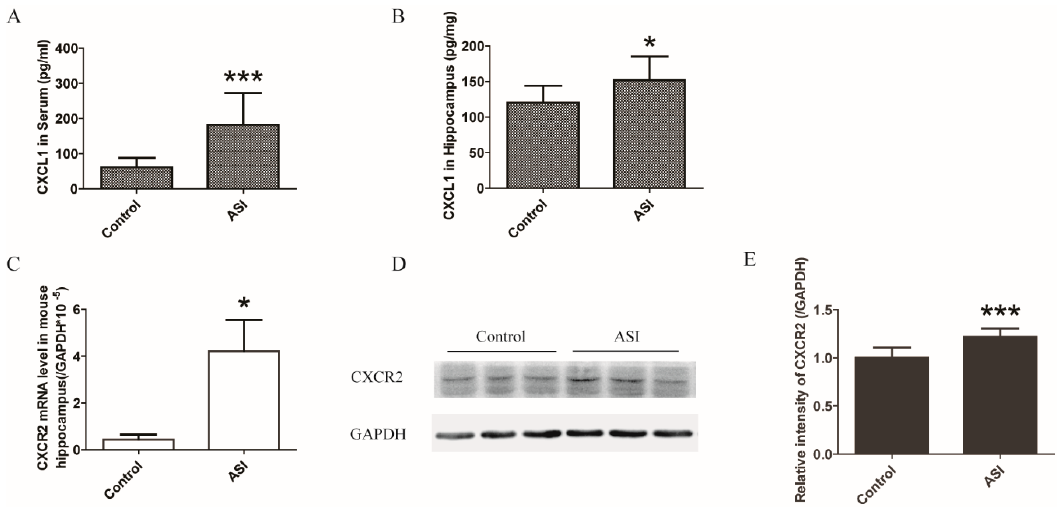
Figure 6. ASI (25 mg/kg) promoted neurogenesis through CXCL1/CXCR2 signaling pathway. ( A , B ) ASI promoted protein expression of CXCL1 in mouse serum and hippocampus ( n = 10/group); ( C ) ASI enhanced CXCR2 mRNA expression level in mouse hippocampus ( n = 6/group); ( D ) Western blotting analysis of CXCR2 in hippocampus; ( E ) Gray intensity analysis of CXCR2 in the hippocampus of mice ( n = 8/group). * p < 0.05; *** p < 0.001. The data are presented as mean ± SD. Table 1. The effect of ASI on mRNA expressions of eighty-four neurogenesis related genes.